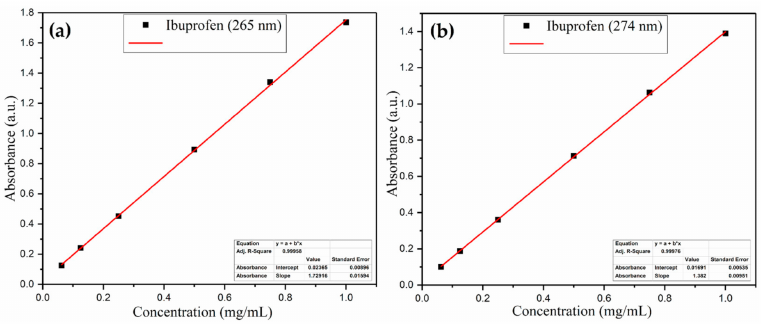
Figure 2. Standard calibration curve of Ibuprofen at 265 nm ( a ) and 274 nm ( b